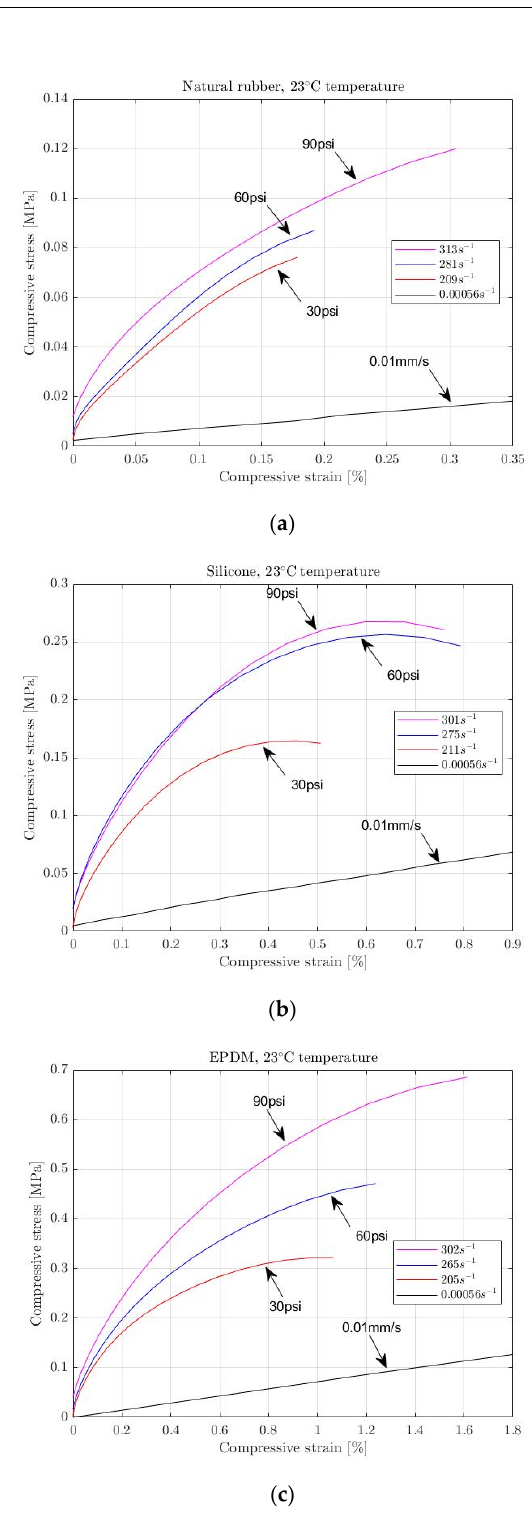
Figure 1. High-strain-rate vs. low-strain-rate compression of ( a ) natural rubber, ( b ) silicone and ( c ) EPDM at ambient conditions.